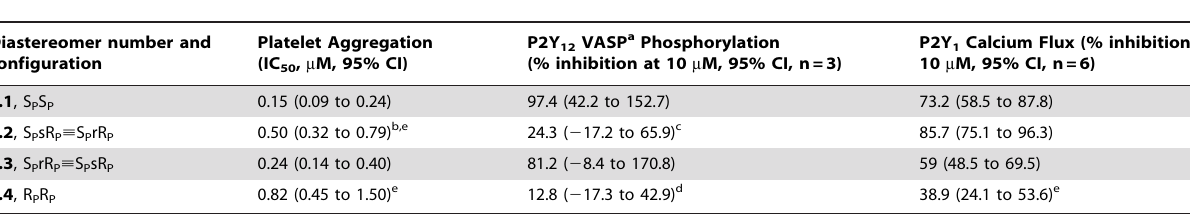
Table 1. Platelet-related properties of the four diastereomers of compound 1 .